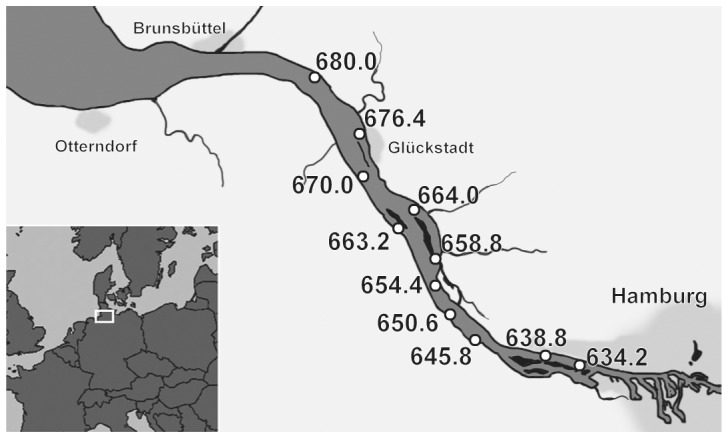
Sampling sites along the lower part of the Elbe River between the North Sea and Hamburg harbor.Areas shaded in light grey are municipalities. Sampling was done in autumn 2006.